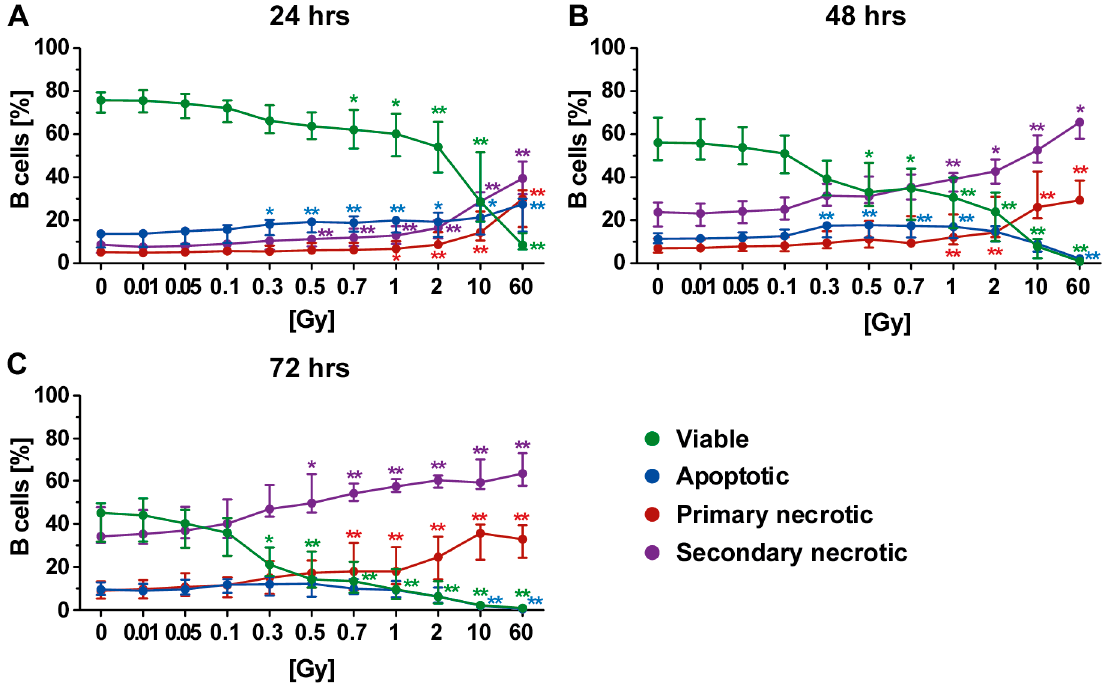
Figure 4. Forms of cell death in B cells at different time points after irradiation. ( A – C ) A high rate of secondary necrotic B cells (violet) was observed, which was time- and radiation-dependent, while low amounts of apoptotic cells were present (blue). Furthermore, a radiation-dependent increase in primary necrotic cells (red) was identified. The colored dots represent the percentage distribution of viable (green), apoptotic (blue), primary (red), or secondary necrotic (violet) B cells as determined by AxPI staining and flow cytometry at ( A ) 24, ( B ) 48, or ( C ) 72 h after irradiation. Each data point represents the median (±IQR) from ten independent experiments of five different donors. Data points have been connected by lines to improve visual clarity. Statistical analyses were performed against the corresponding nonirradiated control (0 Gy) using the Mann–Whitney U test (*: p < 0.05; ** p <